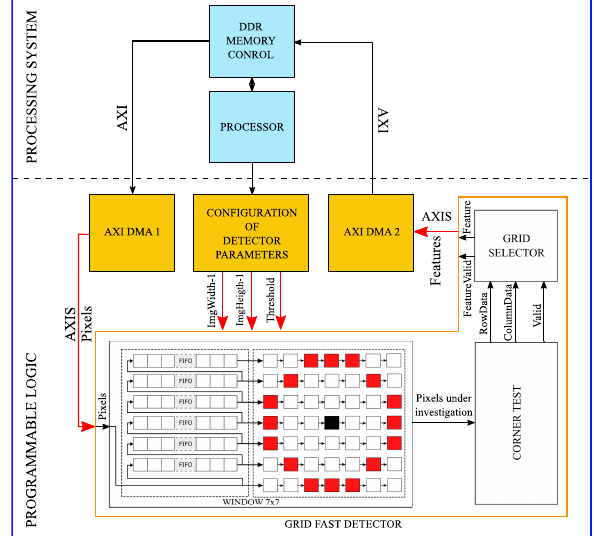
Figure 4. The global design of the grid fast detector implementa- tion.